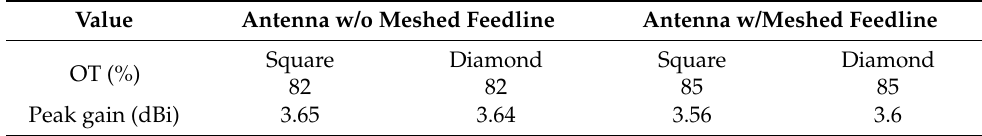
Figure 14. Measured 2-d radiation pattern of antennas with meshed feedline: ( a ) E-plane; ( b ) H-plane. Table 1. Comparison of measured antenna performance.